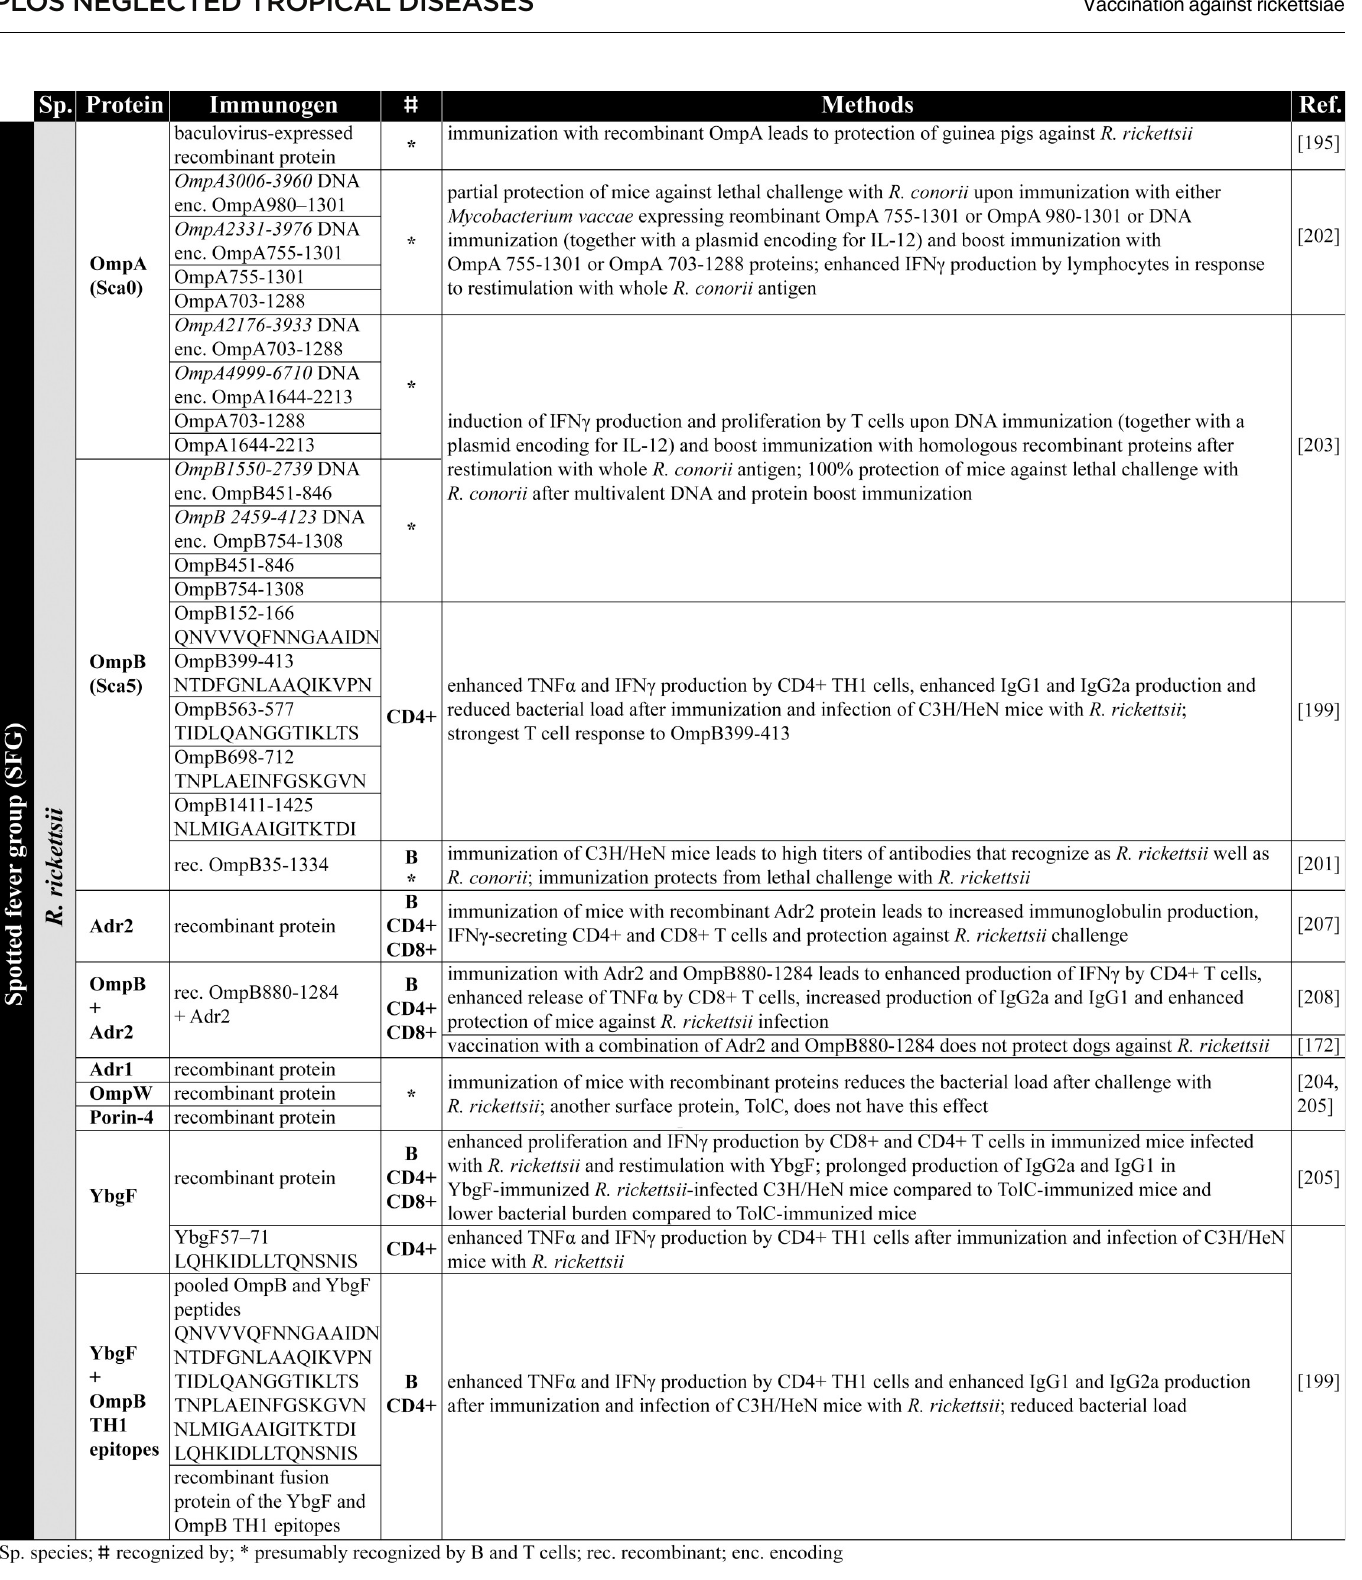
PLOS NeglectedTropical Diseases | https://doi.org/10.1371/journal.pntd.0008704 October 22,